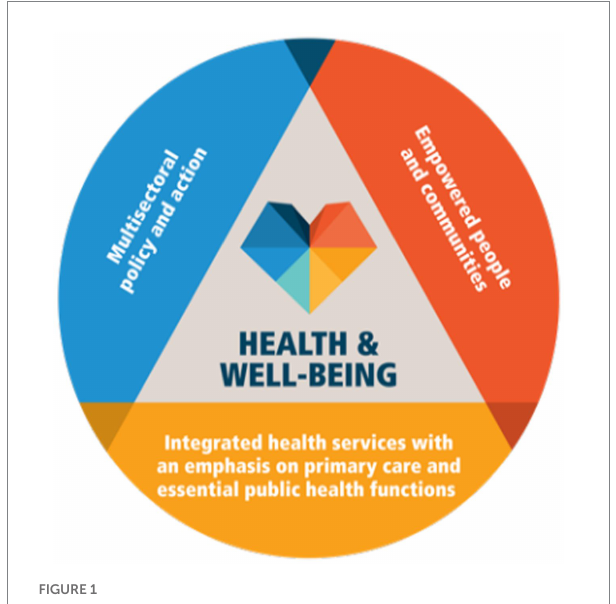
FIGURE 1 Key components of the PHC